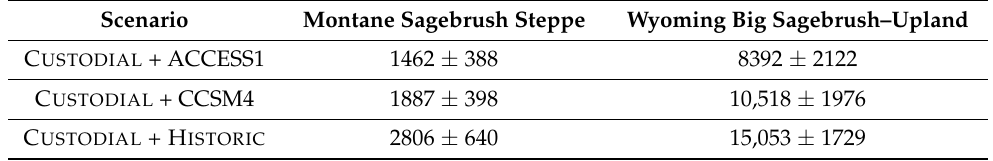
Table 7. Annual area (ha) burned in Montane Sagebrush Steppe and Wyoming Big Sagebrush–Upland under Custodial Management for all three climates. Error is one 95% C.I. N = 10.